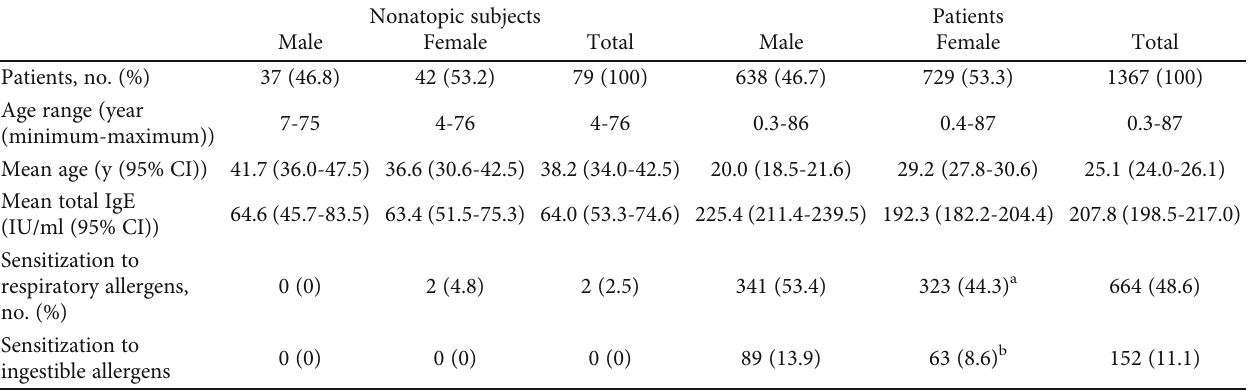
Table 2: Characteristics of all participants regarding age and tIgE.